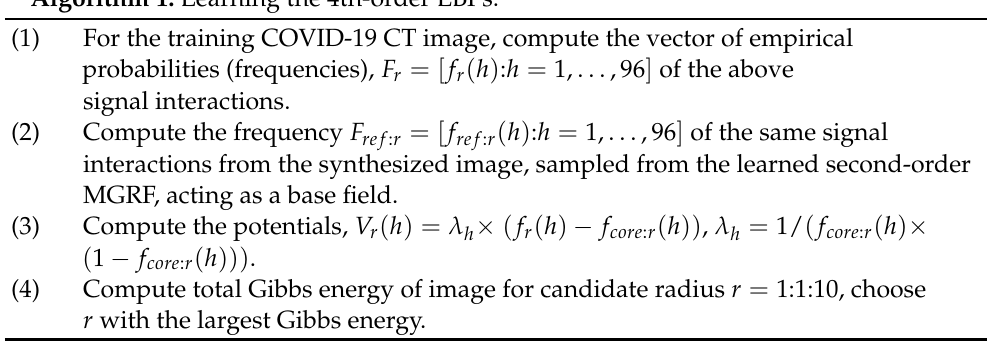
Figure 4. fourth-order LBP structure, g 0 is the central pixel, g 1 , g 2 , g 3 , and g 4 are the four neighbours, and r is the radius. Algorithm 1: Learning the 4th-order LBPs.